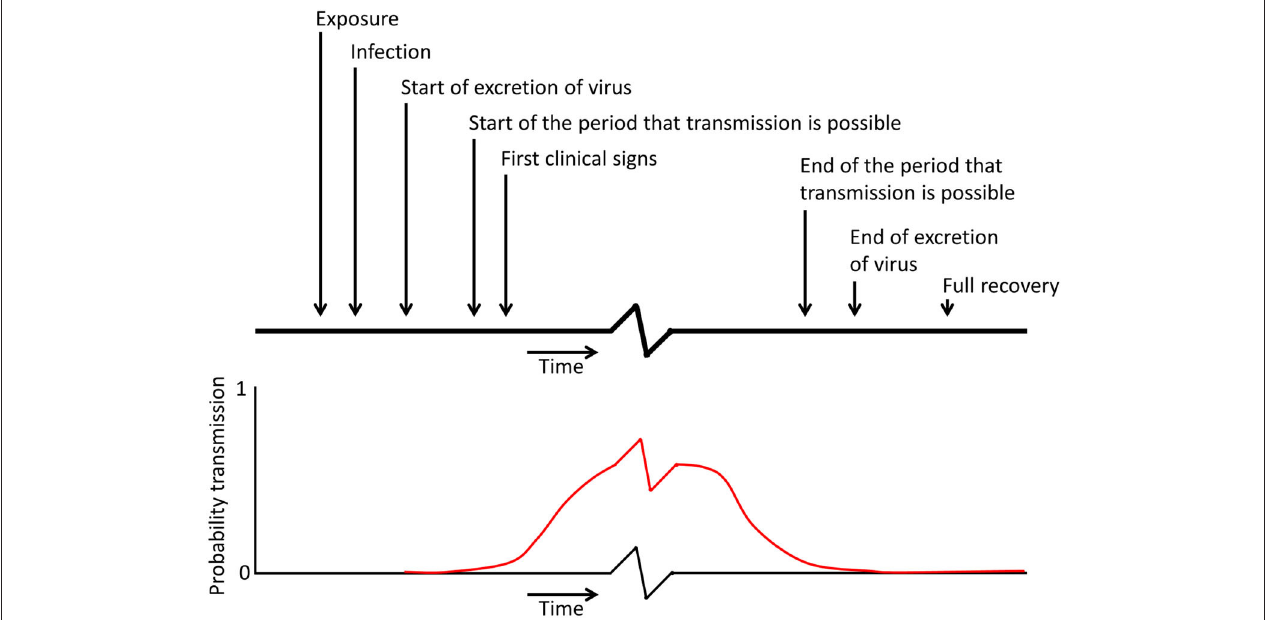
FIGURE 1 | Schematic representation of the different moments in time during infection, which can be used in models to describe the infection process (the x axis and the red curve showing the probability of transmission contain a break as the period in which transmission can occur is probably relatively longer than the other periods indicated on the top of the